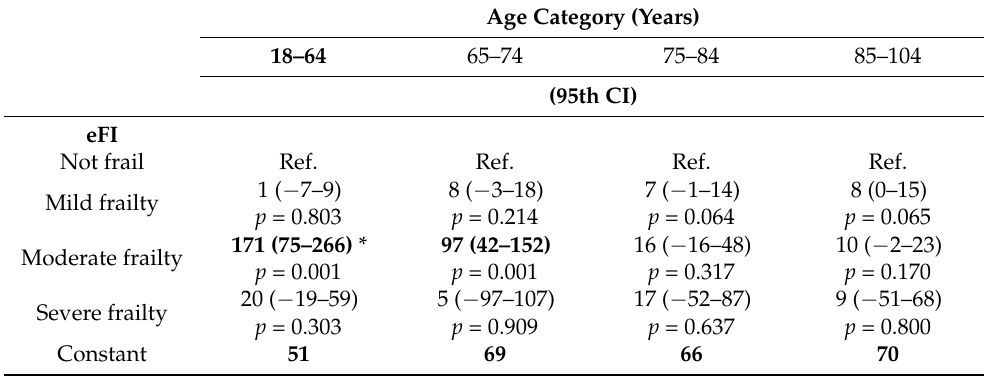
Table 3. Median time to diagnosis (days) by level of frailty, stratified by age.